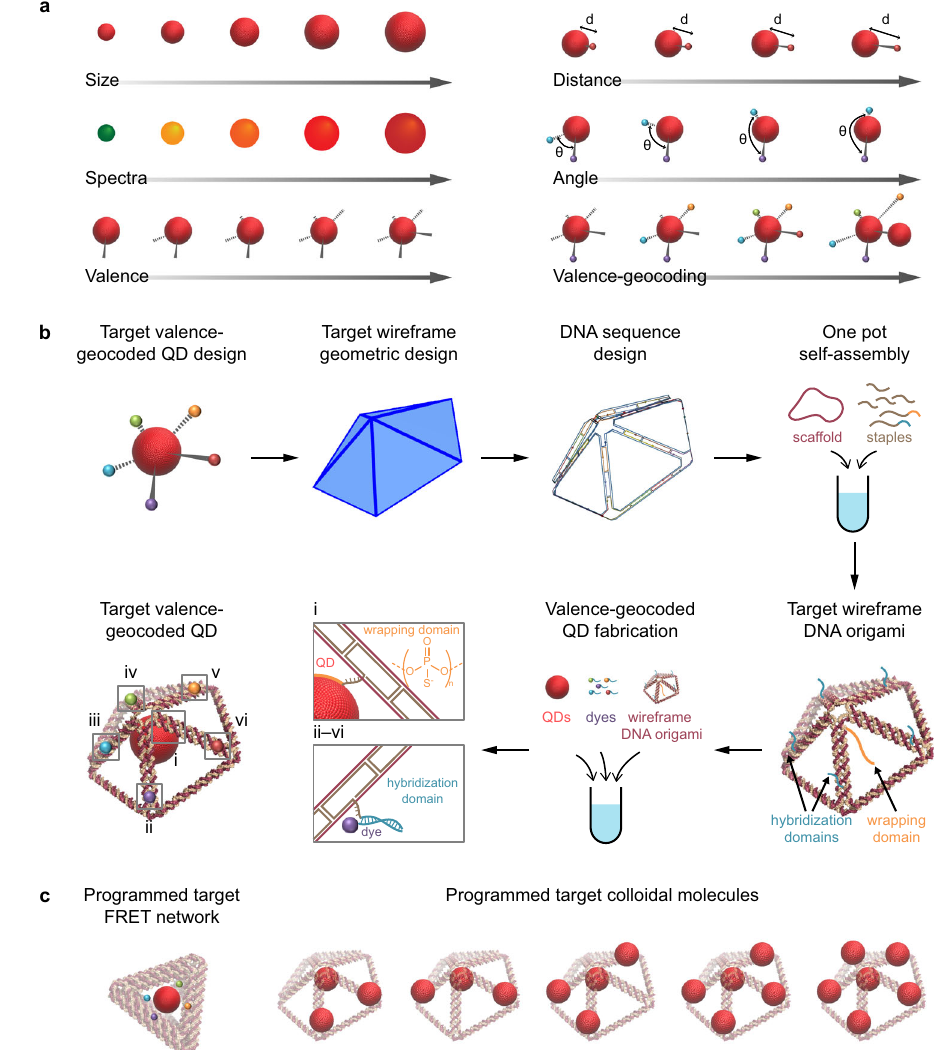
Fig. 1 | Strategy to design and fabricate valence-geocoded QDs. a Schematic of capabilities of valence-geocoded QD. We developed a strategy that combines the size and spectral tunability of QD with ssDNA wrapping strategies and wireframe DNA origami to spatially coordinate the 3D assemblies of QD networks. b Schematic of work fl ow to design and fabricate target valence-geocoded QD via self-assembled wireframe DNA origami objects. The QD-wireframe DNA origami